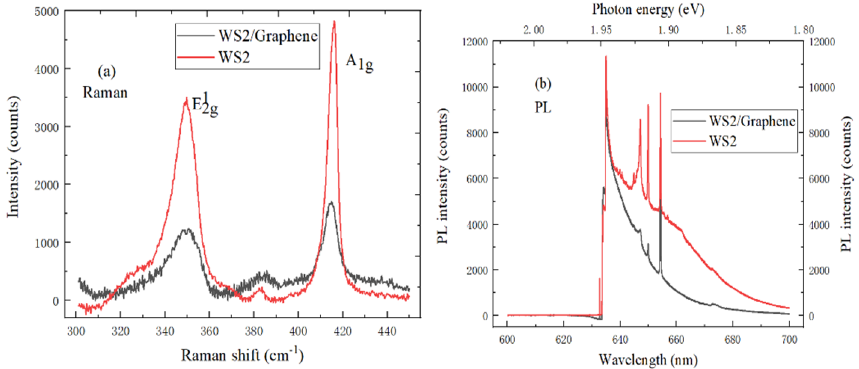
Figure 9. ( a ) Raman spectrum (10 mW, 633 nm), ( b ) PL spectrum (20 mW, 633 nm) characteristics comparison of WS 2 and WS 2 /graphene heterostructure.